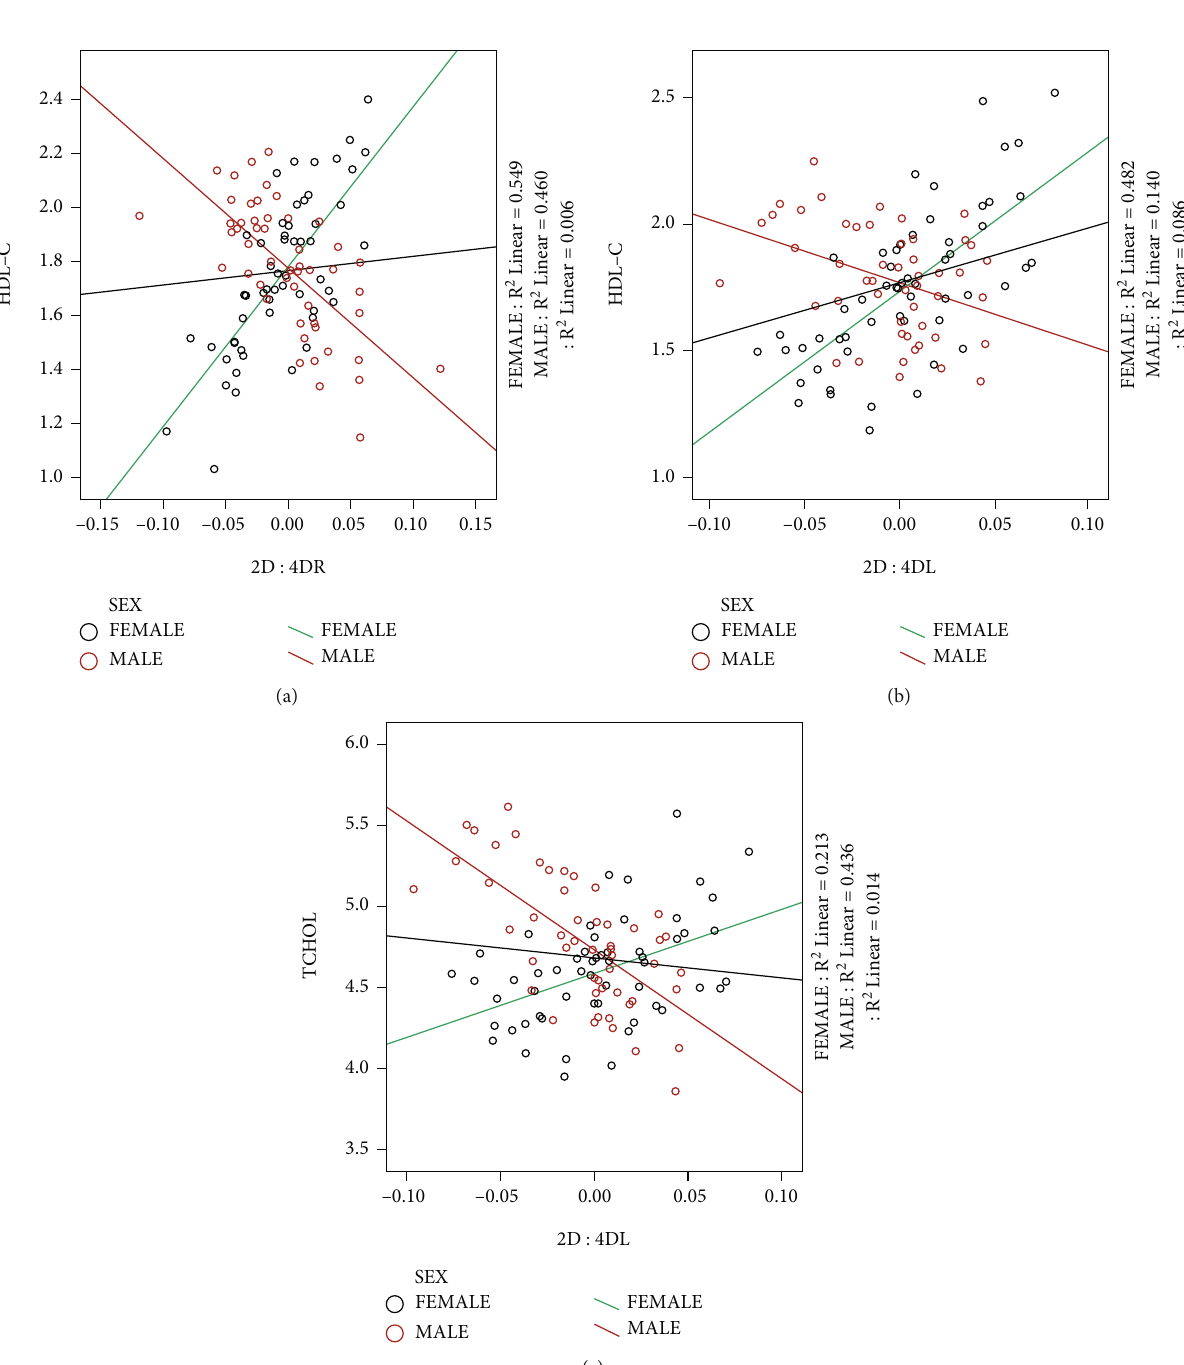
Figure 1: Linear regression plots with interactions between sex and 2D:4D ratio on lipid variables. Interactions between sex and 2D:4DR on HDL-C (a); interactions between sex and 2D:4DL on HDL-C (b); interactions between sex and 2D: 4DL on TCHOL (c). The 2D:4D values on the X -axis were centered on the mean, and the values on the Y -axis are the unstandardized predicted values of the dependent variable (HDL-C and